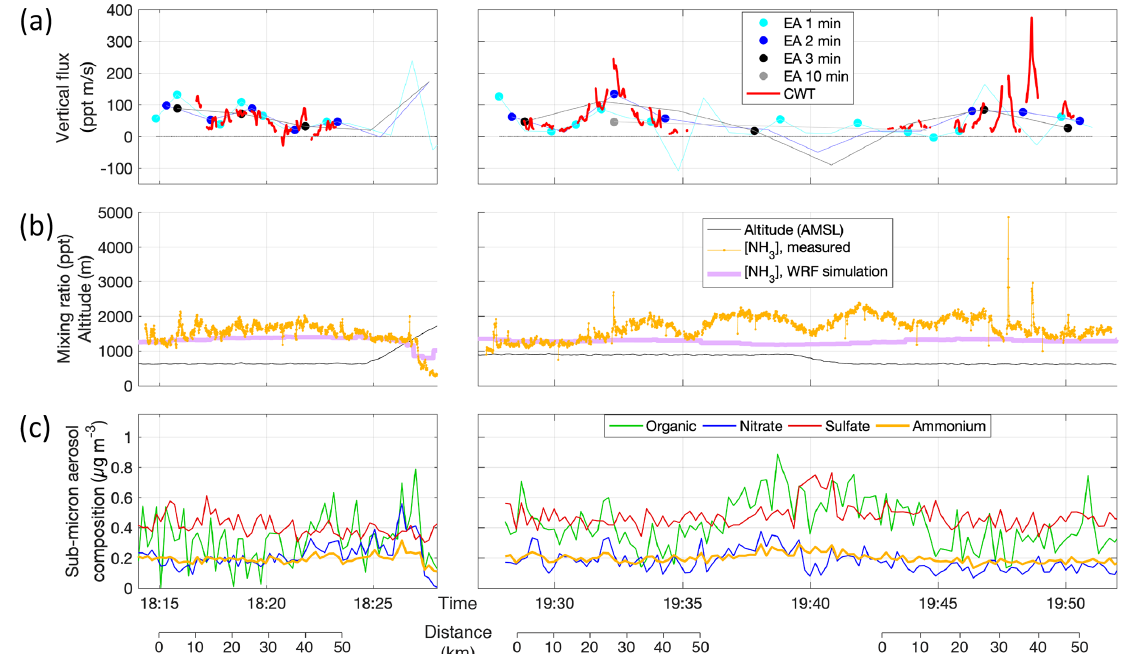
Figure 6. (a) Eddy-covariance NH 3 flux calculation results for three legs within the mixed boundary layer during RF13 on 14 May. The first and third leg were flown at 310–320m above ground; the second leg at 580m and directly above the third one but in opposite direction. Thin lines without markers connect all results using the ensemble-average method (EA); circles mark those results that fulfilled the quality criteria (stationarity test, lag correlation, altitude stability). EA fluxes were determined for time windows of lengths 1 (cyan), 2 (blue), 3 (black) or 10min (gray), ± 50% each. Note that straight-and-level legs were required for obtaining sensible values for EA fluxes, leading to erratic results during climbs (after 18:25UTC) and descents ( ∼ 19:40UTC) that did not pass quality checks. Quality-controlled flux values obtained using the continuous wavelet transform method (CWT) are shown as red lines (details in text and Figs. 7 and 8). (b) NH 3 mixing ratios as measured (orange) and as in WRF model simulation (purple) along the flight track, together with flight altitude (black), using the same ordinate in units of pptv and ma.m.s.l., respectively. (c) Contributions of nitrate (NO 3 ), sulfate (SO 4 ), ammonium (NH 4 ) and non-refractory organic material to the mass concentration of submicron aerosol particles, as measured by the onboard aerosol mass spectrometer